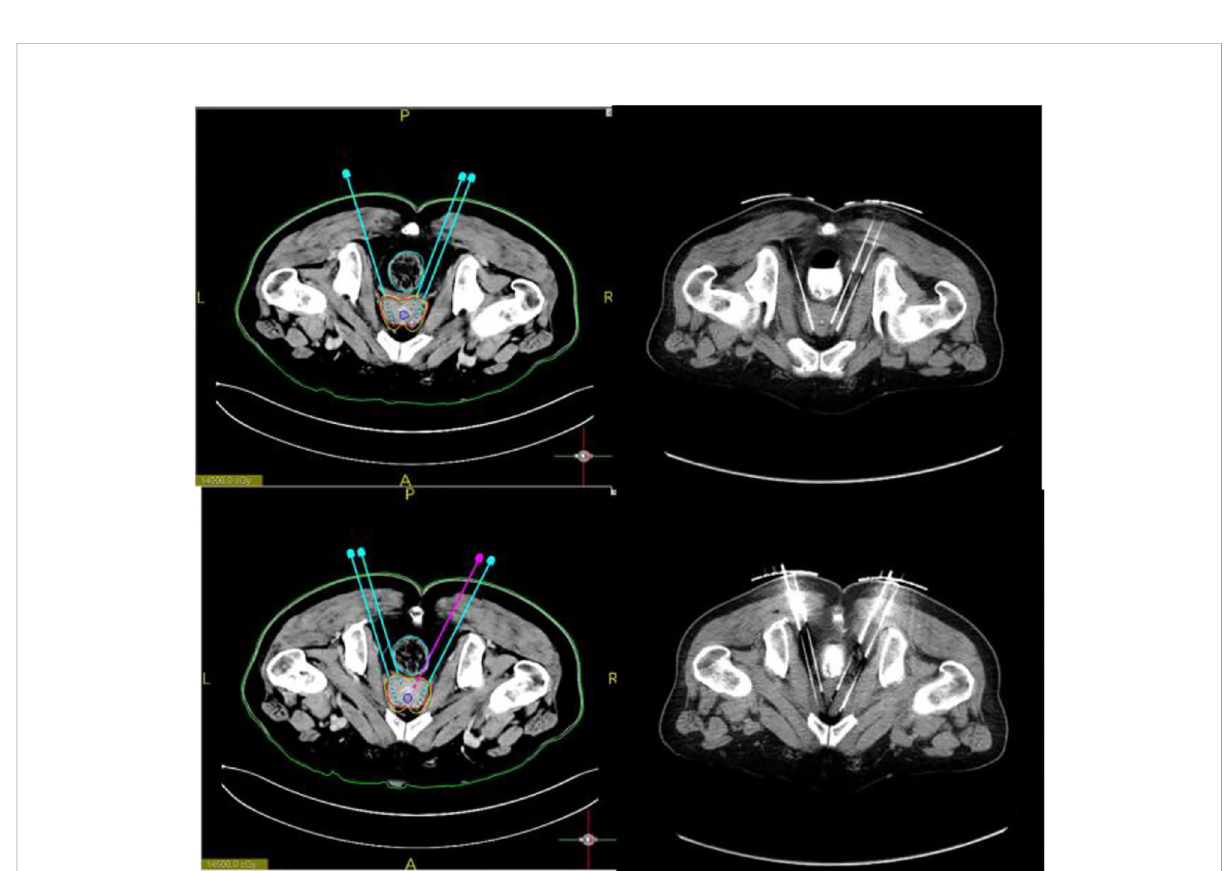
FIGURE 4 Preoperative design. The needle path is planned and particles are loaded to calculate the isometric line distribution. Further, the puncture needle path was accurately implemented during the procedure.